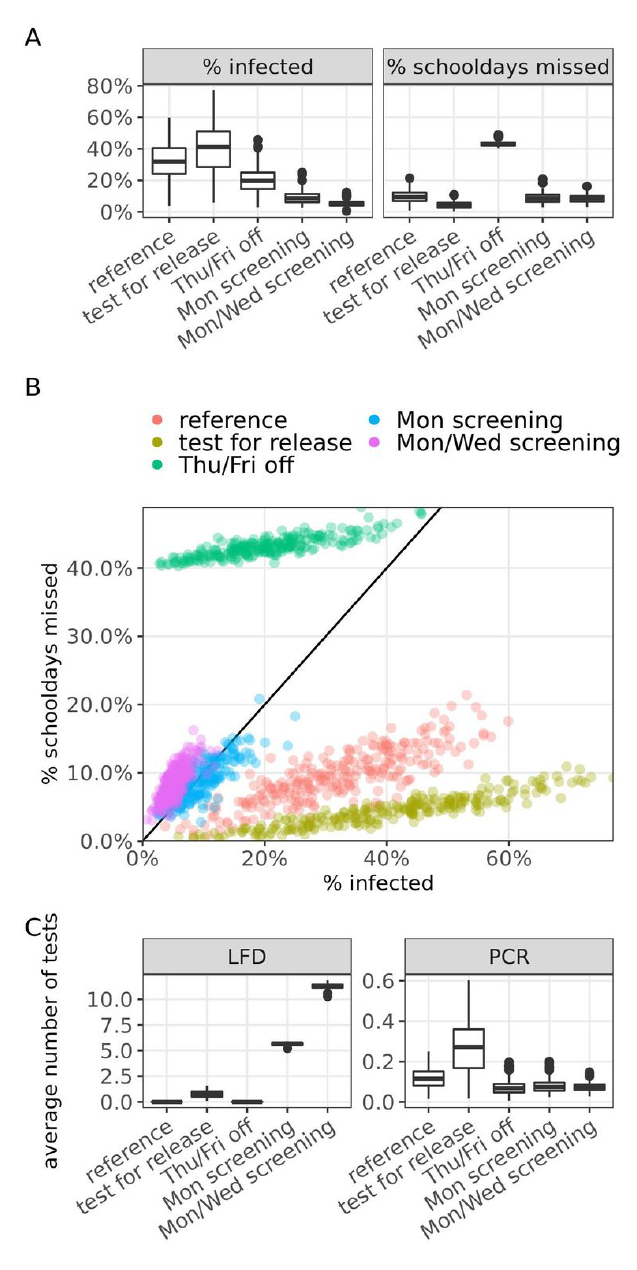
Figure 2. Results for the baseline scenario with , mean presymptomatic lateral flow device (LFD) test sensitivity of 0.6, and 50% asymptomatic cases over the 6-week horizon. A: Box-plots of the distribution of the proportion of infected pupils and the proportion of school days missed; B: Scatterplot of the proportion of missed school days against the proportion of infected pupils of individual simulation runs; black line indicates first bisector; C: Box-plots of the average number of polymerase chain reaction (PCR) and LFD tests per